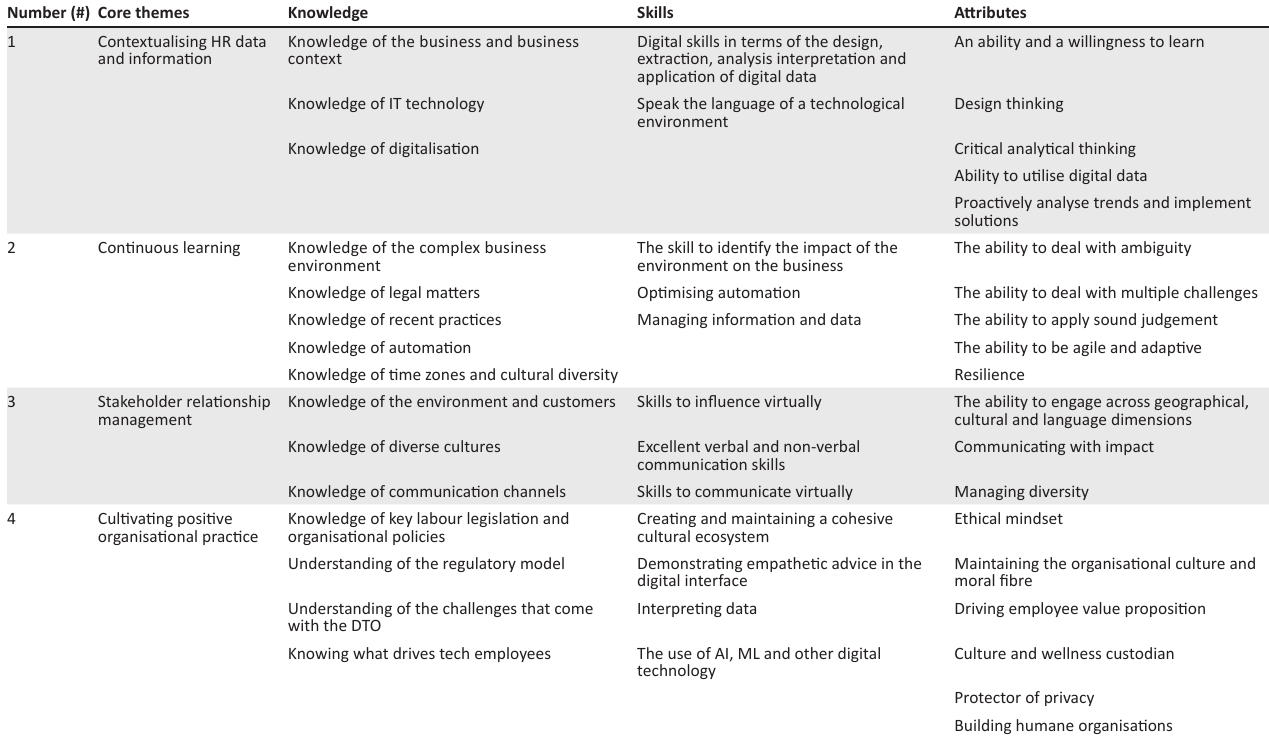
TABLE 1: Core and sub-themes of the study. Number (#) Core